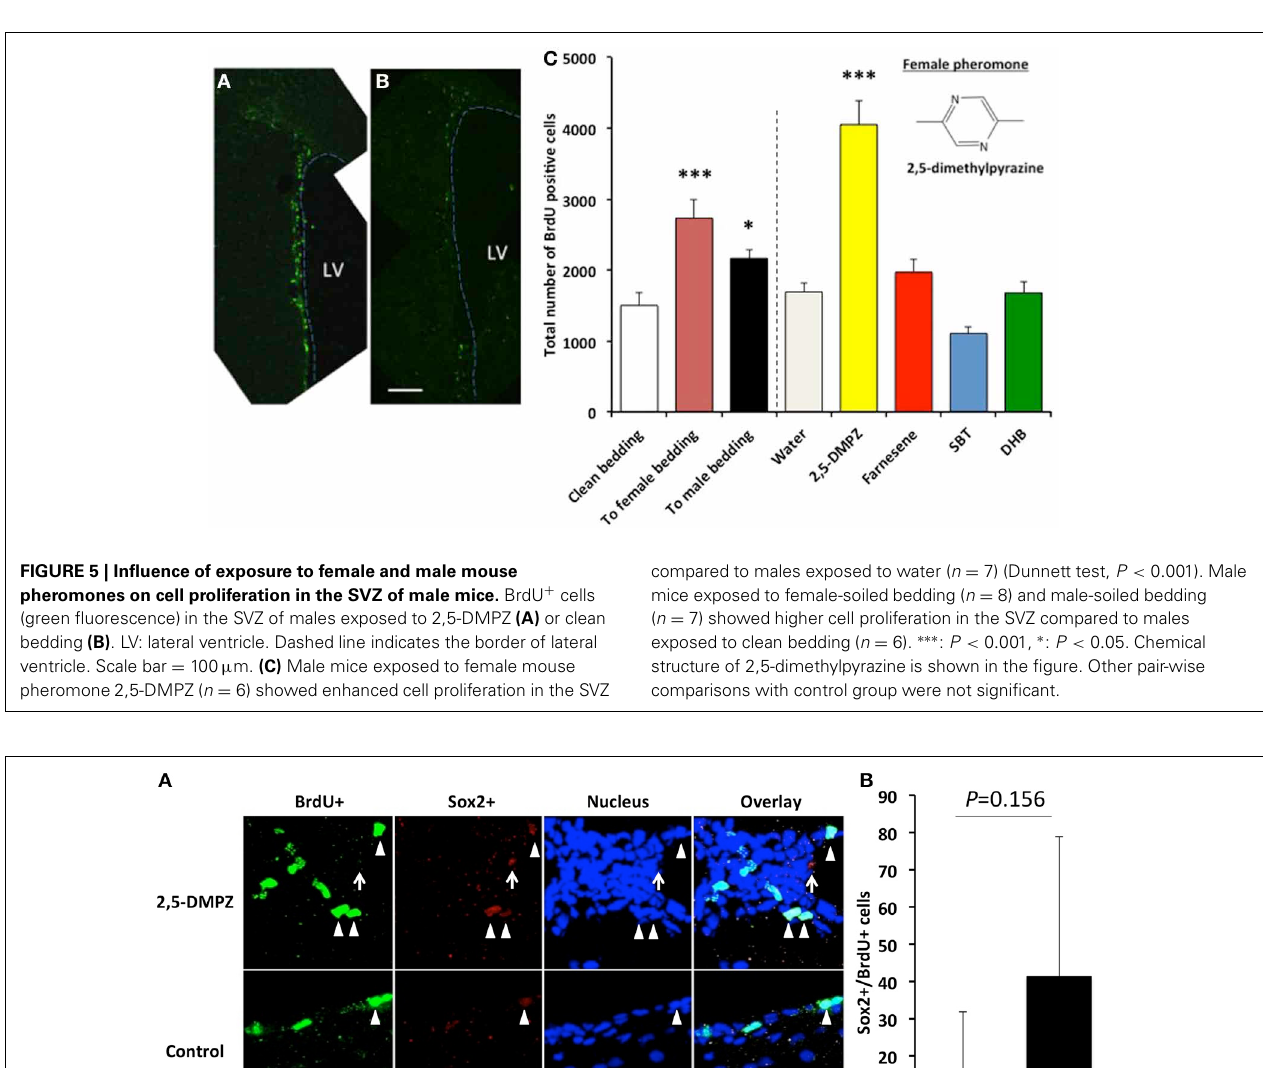
FIGURE 6 | Sox2 expression in the proliferating cells in the SVZ of male mice. (A) Expression of Sox2 in the BrdU + cells (arrow heads) in the SVZ of male mice exposed to 2,5-DMPZ (above) and control group male mice (below). (B) Rate of BrdU + cells doubled labeled with Sox2 +